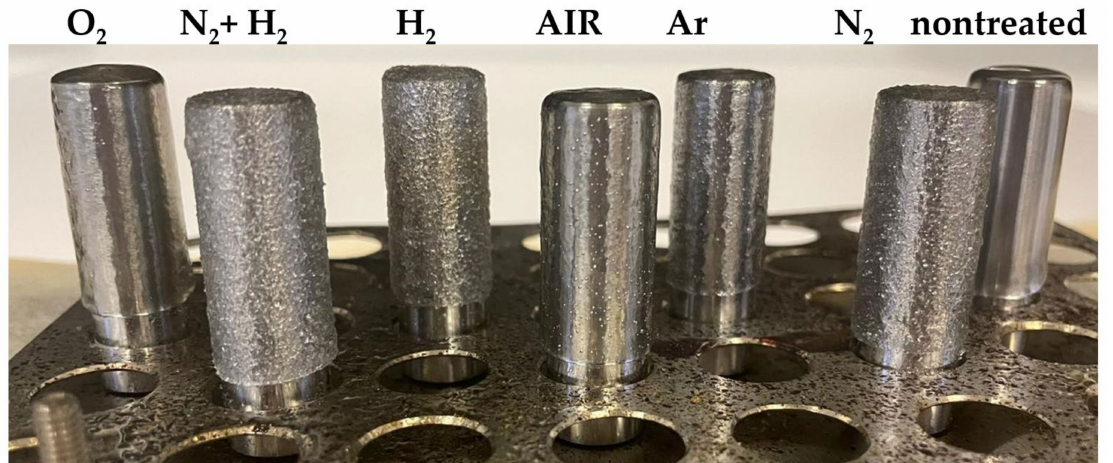
Figure 11. The process of melting polymer powder treated using different gases into metal rod and surface